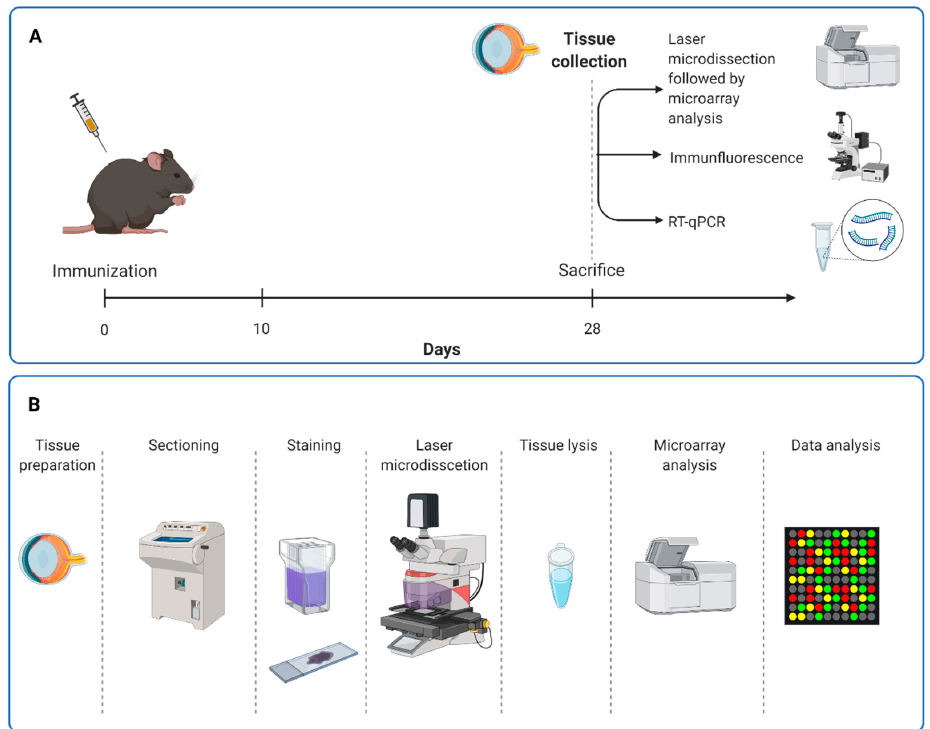
Figure 1. Study design. ( A ) Rats received an intraperitoneal injection with ONA or sodium chloride solution. At 28 days after immunization, the animals were sacrificed, and laser microdissection of the retina followed by microarray analyses were performed. Furthermore, immunohistological staining and RT-qPCR analyses were carried out. ( B ) For microarray analyses, eyes were removed and retinal cross-sections provided. Cresyl violet staining was used to visualize retinal layers, especially neuronal cells. GCL, IPL, and INL were labeled and dissected out by a laser. After dry collection, RNA was isolated for microarray analysis. GCL = ganglion cell layer; IPL = inner plexiform layer; INL = inner nuclear layer.